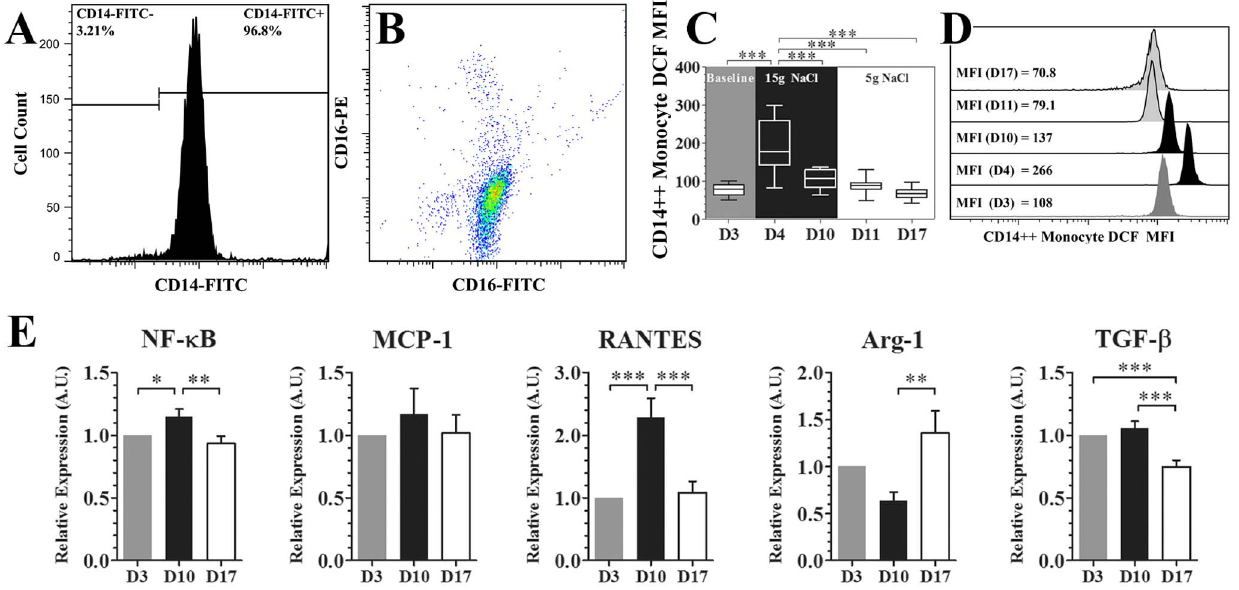
Figure 5. Pro-inflammatory activation of purified CD14 ++ monocytes during dietary intervention. Figures A to B show the purity analysis of CD14-magnetic-bead isolated human circulating monocytes. A, shows the percentage of CD14 ++ cells after CD14 bead purification. B, shows a CD14 versus CD16 color plot using cells after CD14 bead purification. Note that monocyte purified by this method are CD14 ++ monocytes (i.e., CD14 ++ CD16 2 and CD14 ++ CD16 + , according to gating strategies described in Figure 2 ). Figures C and D show intracellular ROS production in magnetic beads purified CD14 ++ monocytes by 2 9 , 7 9 -dichlorofluorescein (DCF) flow cytometry analysis (n=6, one way repeated measures ANOVA).Figure E shows the related gene expression in magnetic-bead-purified CD14 ++ monocytes (n=16, one way repeated measures ANOVA). ‘‘D3’’ to ‘‘D17’’ labeled in the x-axis indicates ‘‘day 3 0 to ‘‘day 17 0 . * P , 0.05, ** P , 0.01, *** P , 0.001. NF- k B indicates nuclear factor kappa B; MCP-1 indicates monocyte chemoattractant protein-1; RANTES indicates Regulated on Activation, Normal T Cell Expressed and Secreted ( or CC chemokine ligand 5, CCL5); TGF- b indicates transforming growth factor b ; Arg1 indicates arginase 1; MFI indicates median fluorescence intensity.